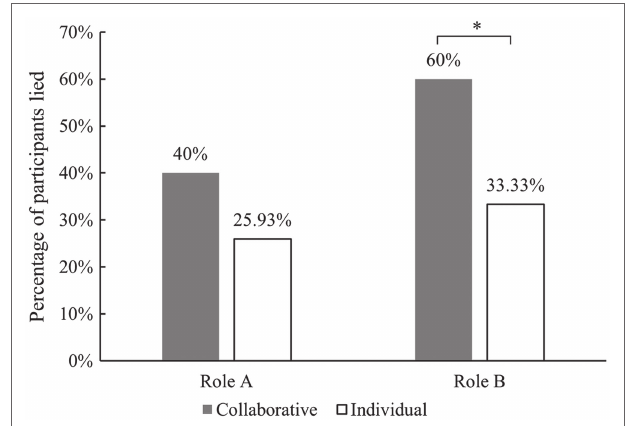
FIGURE 5 | The percentage of dishonest participants in both conditions. * p < 0.05.